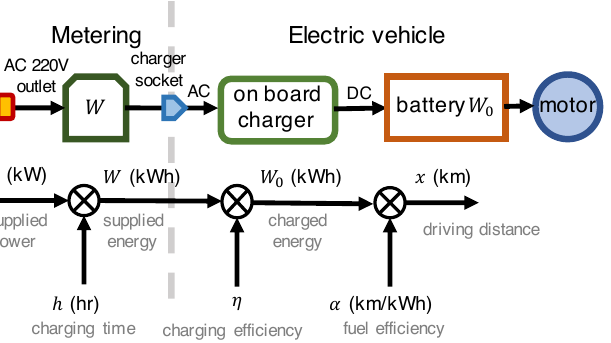
Figure 1. EV charging model for the AC slow charger. The AC power is supplied from a regular AC 220 V outlet a the maximum current of 16 A to the OBC, which converts the AC power to DC power and charges the